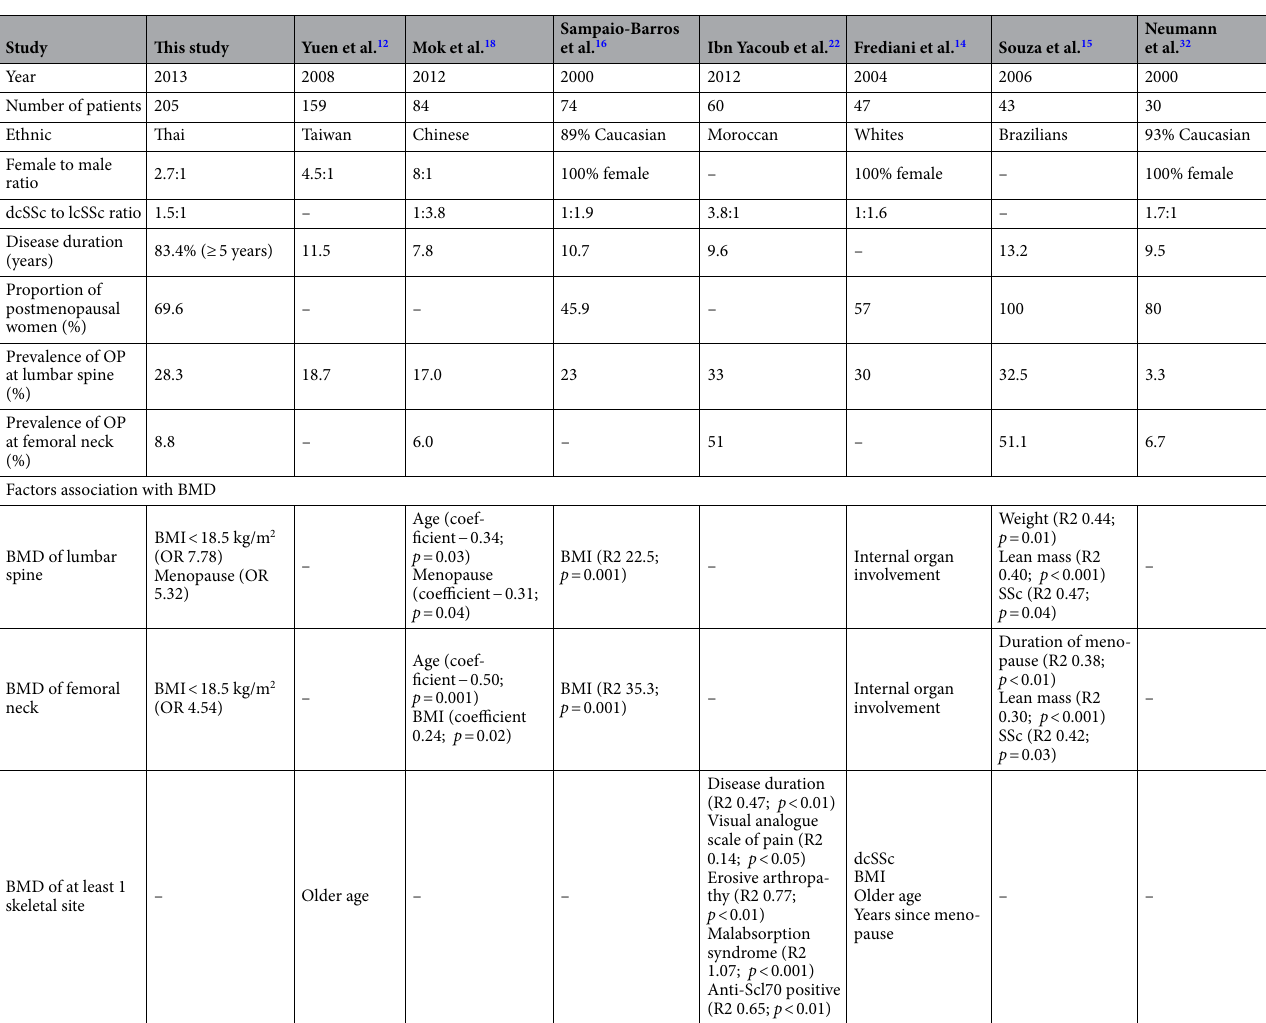
Table 4. Comparison of prevalence and associated factors for osteoporosis in SSc patients. OP Osteoporosis, dcSSc Diffuse cutaneous systemic sclerosis, lcSSc Limited cutaneous systemic sclerosis, BMI Body mass index, – No data, BMD Bone mineral